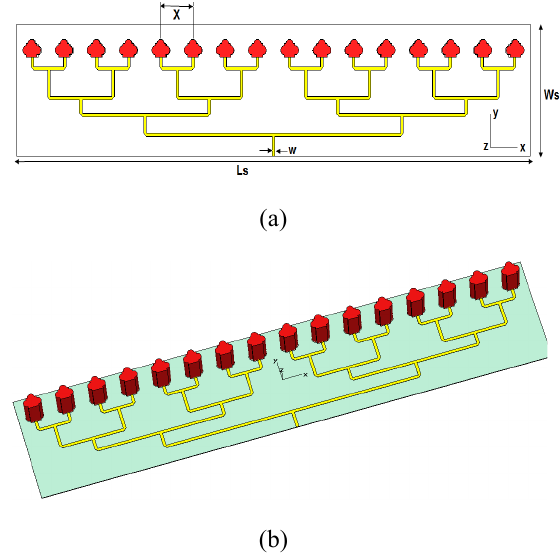
Figure 6: Geometry of the proposed NDRA view (b) 3D view